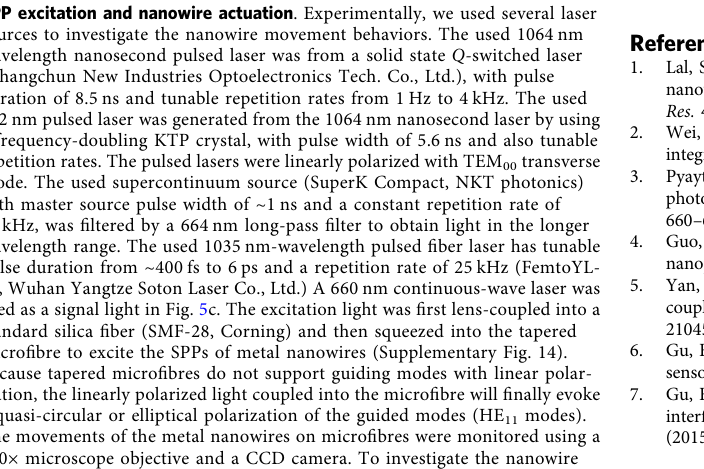
( D fi ber = 1.8 μ m). f Sorting of an Au nanowire ( L NW = 3.8 μ m) using two contact micro fi bres. All actuation lasers used here are the 1064 nm pulsed lasers with average input power ranging from ~20 to 300 μ